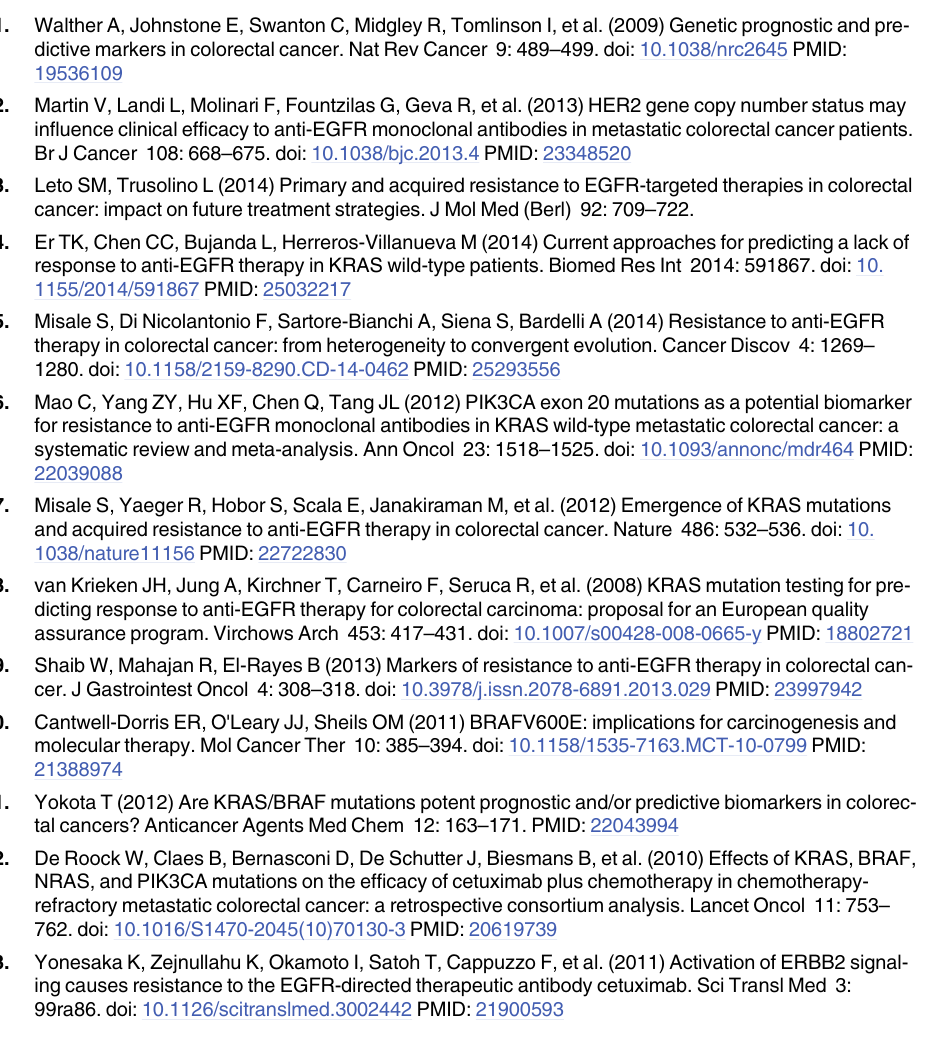
S2 Table. The basic clinicopathologic findings of each patient. S3 Table. Multivariate analysis for factors predictive of survival (Cox proportional hazards model). S4 Table. Association between clinicopathologic characteristics and BRAF or HER2 alter- ations in KRAS wild type